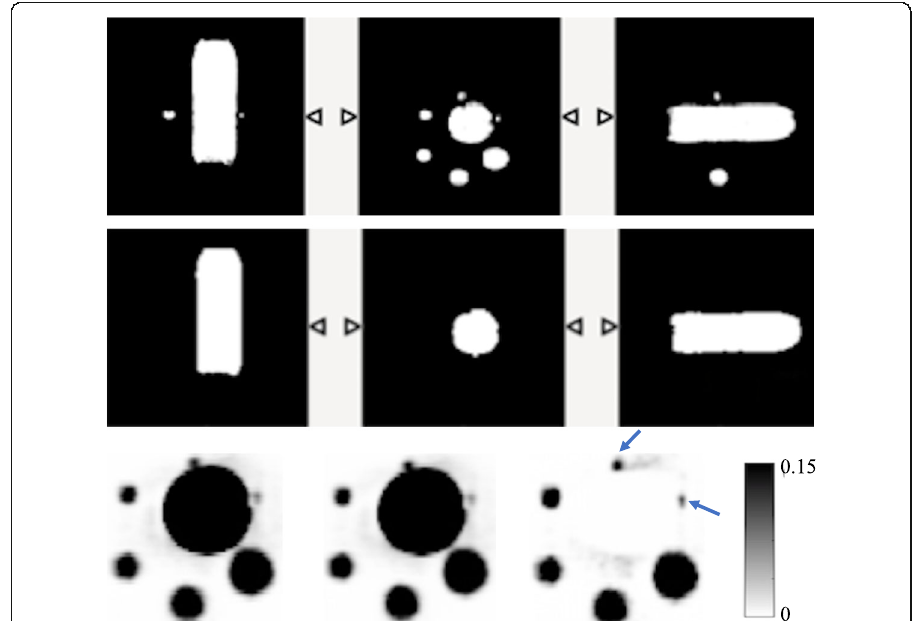
Fig. 9 The NEMA bottle phantom used for the validation. The first row shows the MRAC image of the phantom and the middle row is the segmented bottle from the MRAC image, while the last row is showing the coronal view of the reconstructed images at three full iterations with a 4-mm Gaussian filter for OSEM, OSEM+PSF and OSEM+PSF+BC reconstructions, respectively. The blue arrows in the reconstructed images are pointing to the spheres in which there is visual improvement